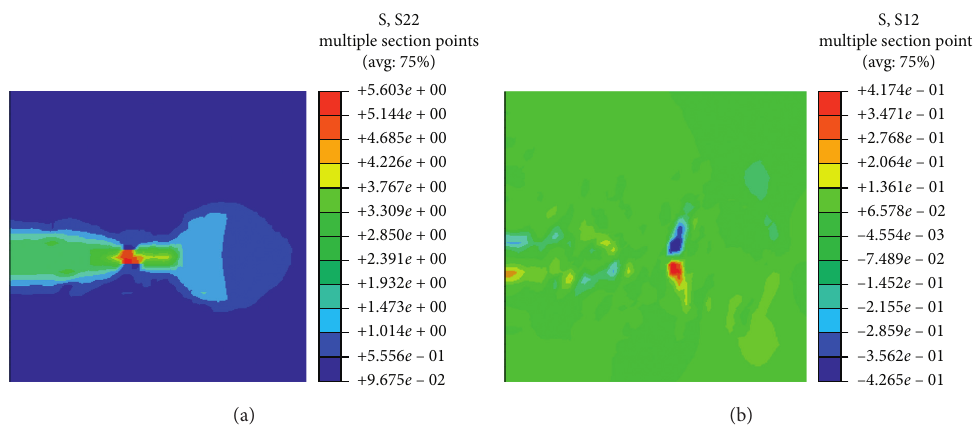
Figure 12: Adhesive layer stress of high-elastic-modulus CFRP paste repair. (a) Normal stress. (b) Shear stress.